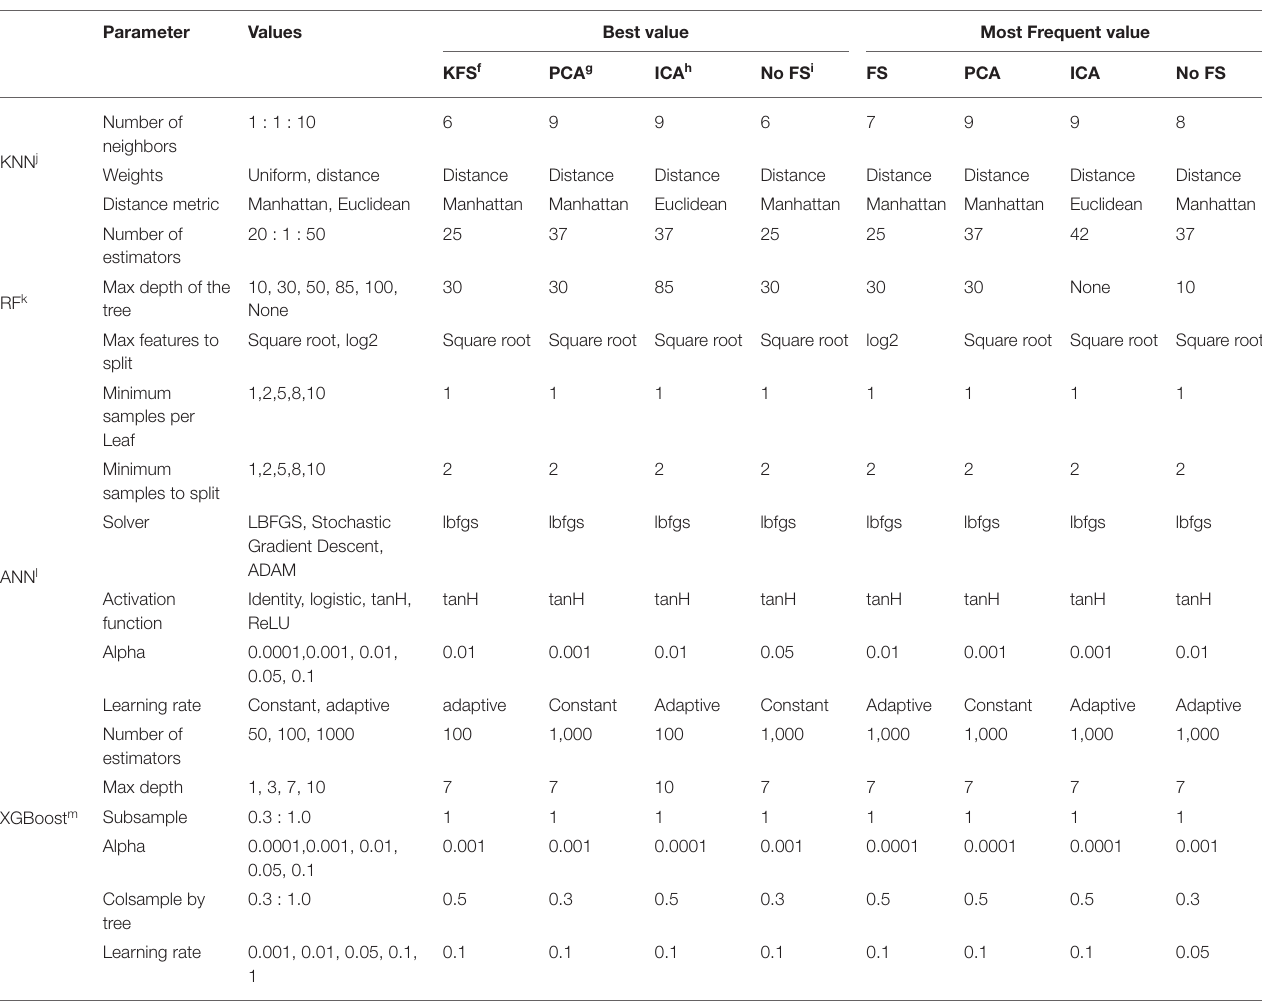
TABLE 2 | Table summarizing the tuned hyperparameters for each model and the corresponding best and most frequent